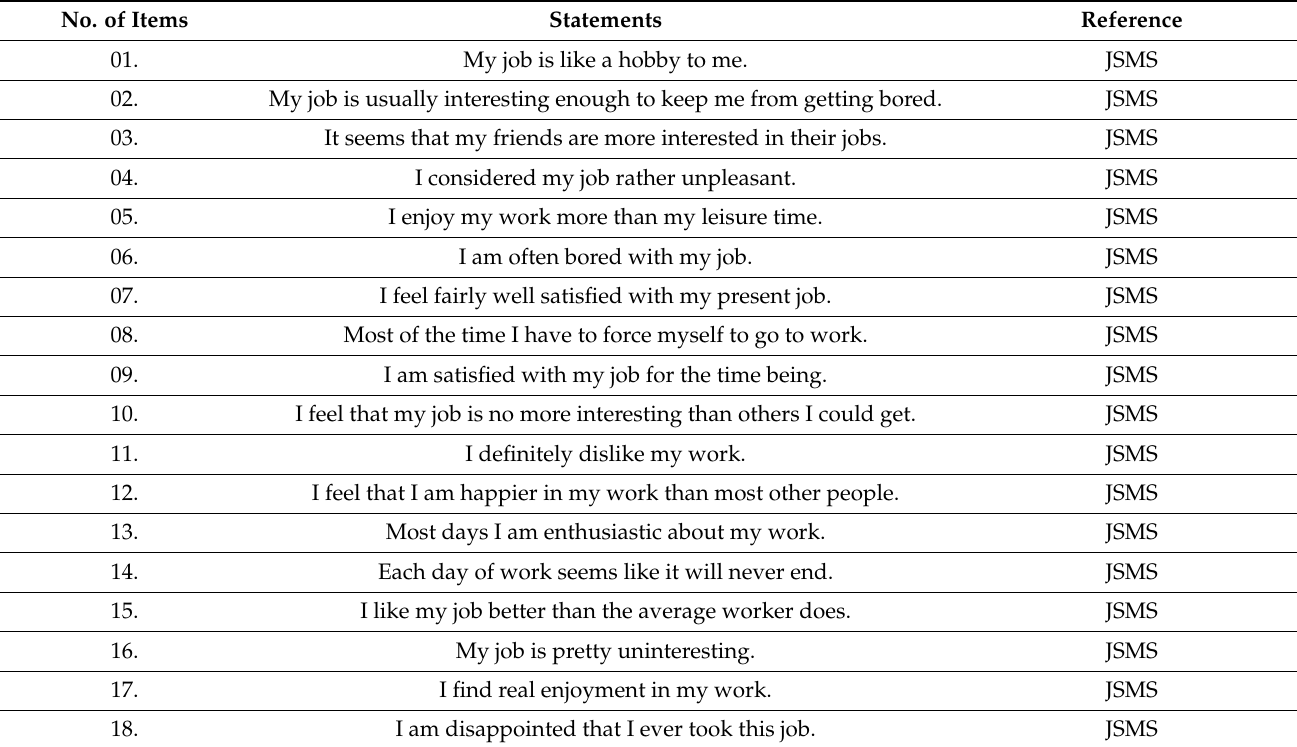
Table A1. Overview of Baryfied-Rothe’s job satisfaction